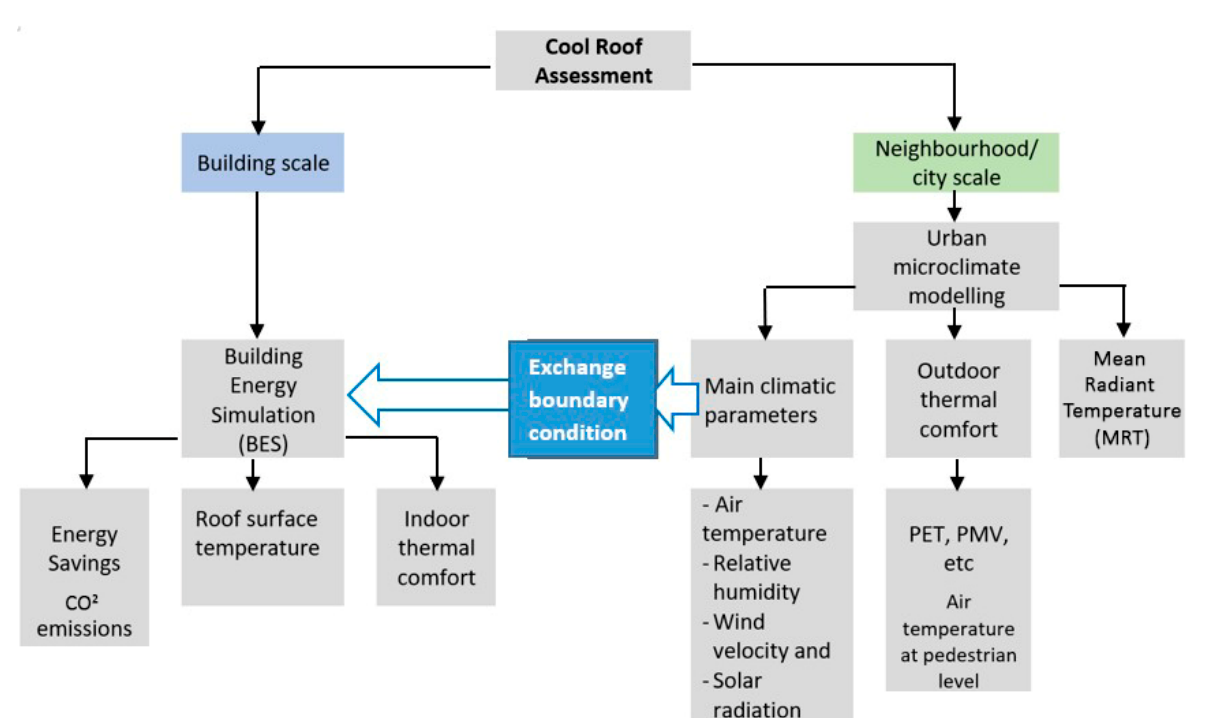
Figure 4. A general framework for cool roofs, illustrating the different assessment scales and tested Figure 4. Ageneralframeworkforcoolroofs, parameters.